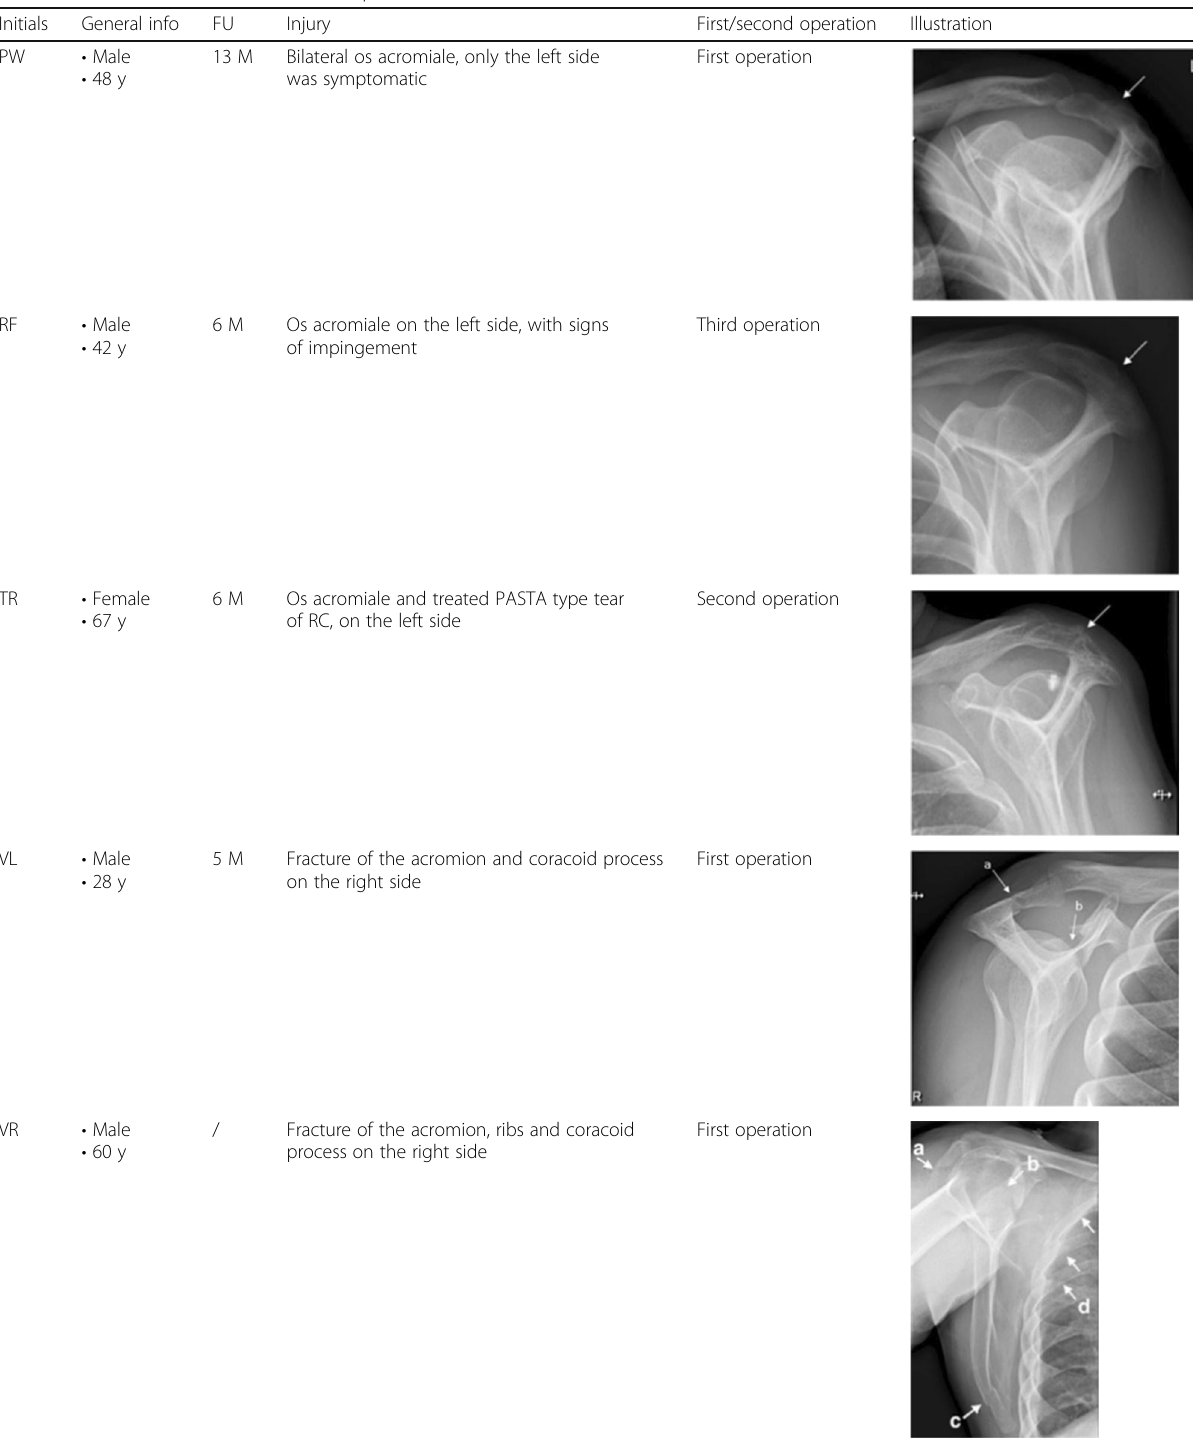
Table 2 General information about the